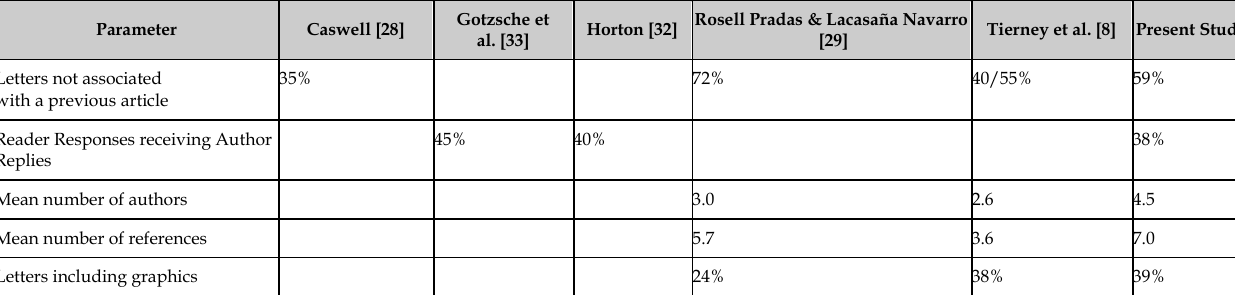
Table 2 Study Results Compared with Results from Previous